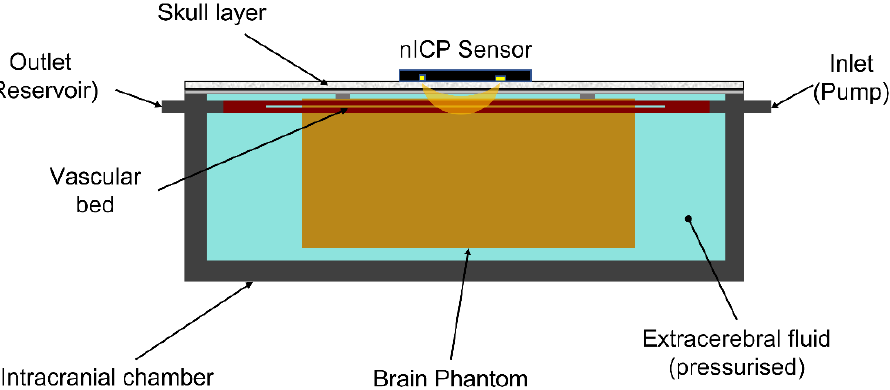
Figure 2. Representation of the intracranial chamber environment. The brain phantom is enclosed in the chamber, and its vascular bed is connected to the chamber’s inlet and outlet, connected to the pulsatile pump and reservoir, respectively. The brain phantom is surrounded by pressurised extracerebral fluid (deionised water). The intracranial chamber is then sealed with an acrylic cover and an opaque skull layer diffusing light from the nICP sensor.